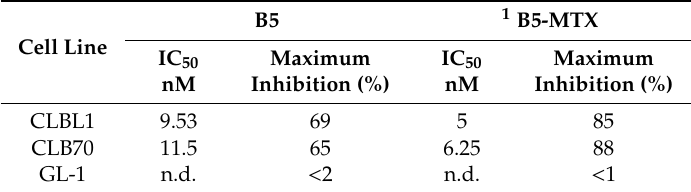
Table 1. In vitro cytotoxicity of mAb B5 and B5-MTX in canine lymphoma / leukemia cell lines.